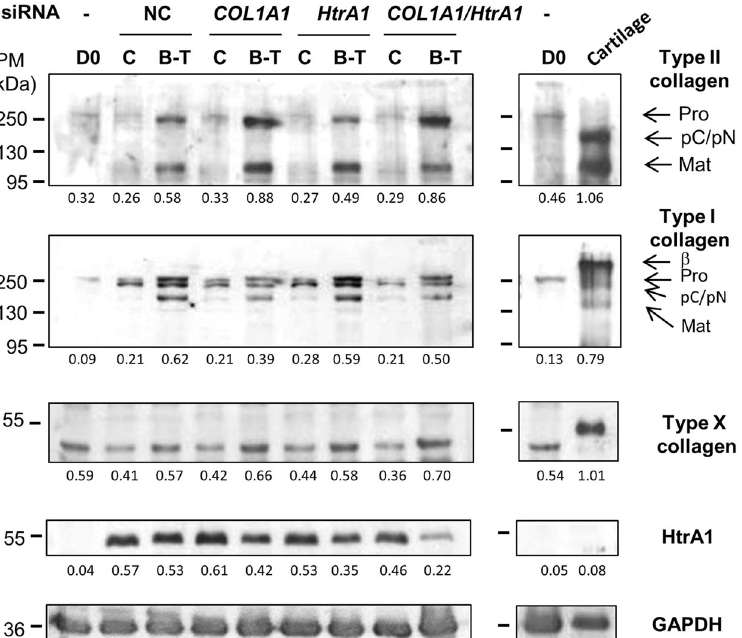
Figure 7. Effects of COL1A1 and/or HtrA1 siRNA on collagen and HtrA1 synthesis. hBM-MSCs were cultured under hypoxia with or without BMP-2/TGF- β 1 (B-T), and transfected with NC, or COL1A1 and/or HtrA1 siRNAs in type I collagen sponges for 14 days, as described in Fig. 6. Protein extracts from treated-MSCs, undifferentiated MSCs at day 0 (D0), and a macroscopically healthy zone of human OA cartilage were analyzed by Western-blotting for type I, II, and X collagens, and HtrA1 versus GAPDH. Different exposures of the blots are provided in the supplementary information file (Fig. S6). Corresponding quantifications of the bands of interest, normalized to the GAPDH signals, are indicated as arbitrary units below each blot. Representative blots are